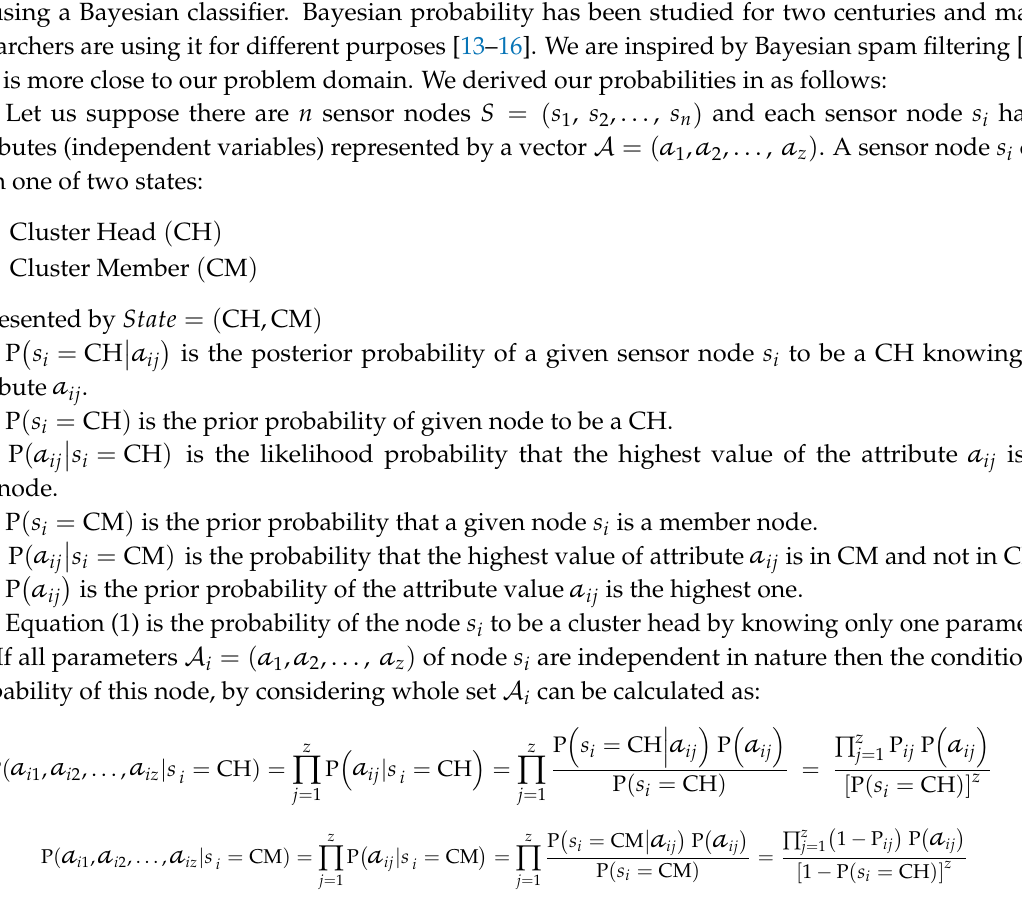
Figure 4. Dynamic clustering scheme.